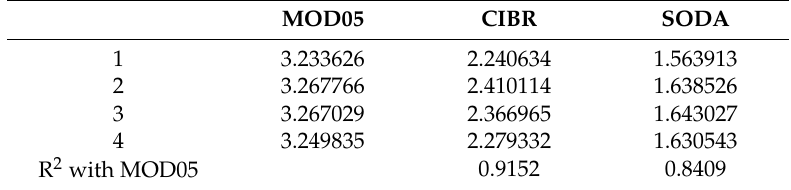
CIBR, Continuum Interpolated Band Ratio; SODA, second-order difference